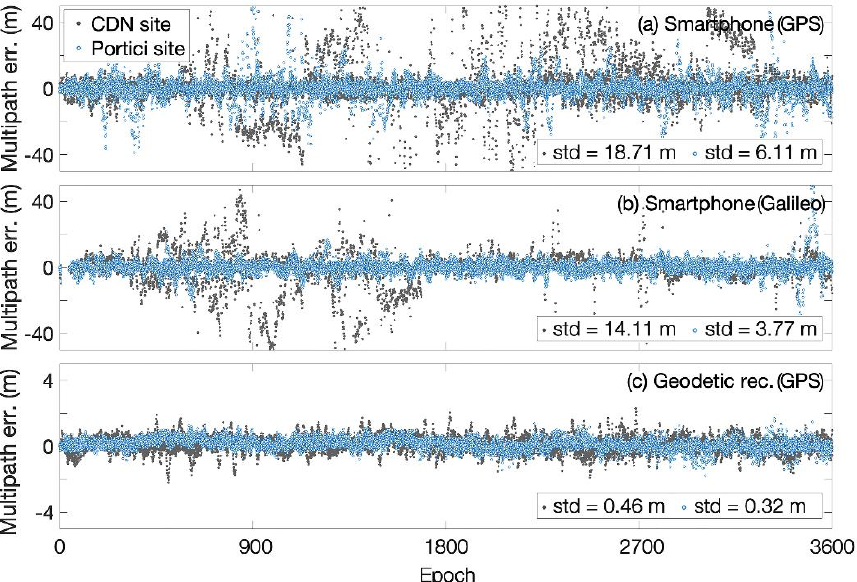
Figure 5. L1/E1 code multipath error for CDN site (represented in grey) and Portici site (represented in blue) versus processed time expressed in epochs. ( a ) L1 code multipath for all GPS satellites tracked by smartphone; ( b ) E1 code multipath error for all Galileo satellites tracked by smartphone; ( c ) L1code multipath error for GPS satellites tracked by geodetic receiver.